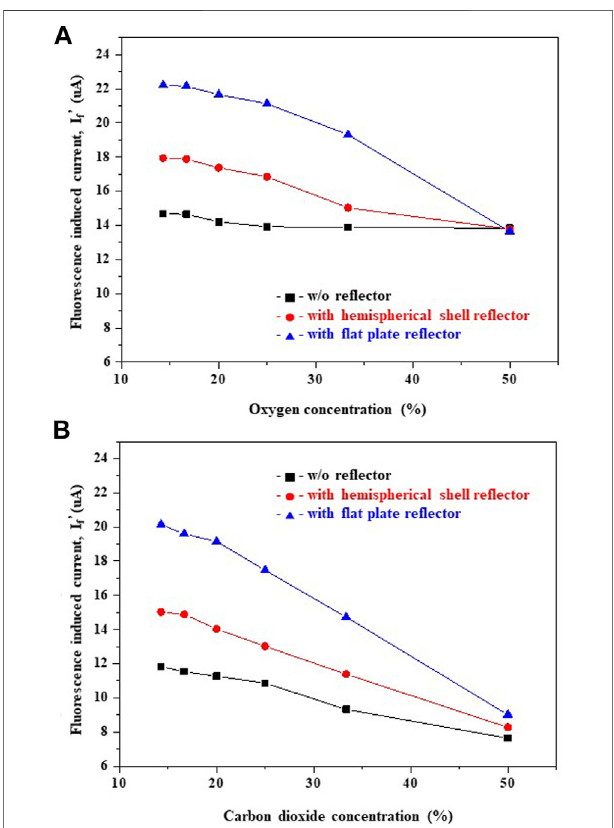
FIGURE 10 | Responses for gas sensors of three different designs: (A) fl uorescence-induced photo-currents I f detected by gas sensors under different O 2 concentrations, and (B) fl uorescence-induced photo-currents I f detected by gas sensors under different CO 2 concentrations.